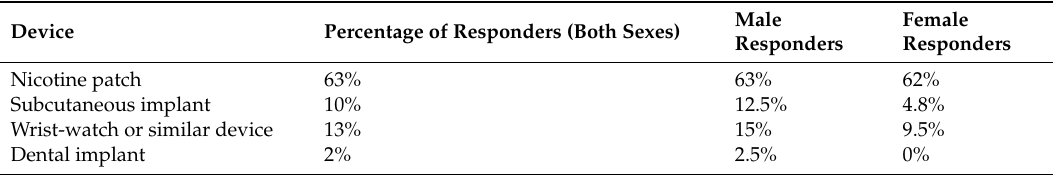
Table 3. Preferred devices for transdermal sensor